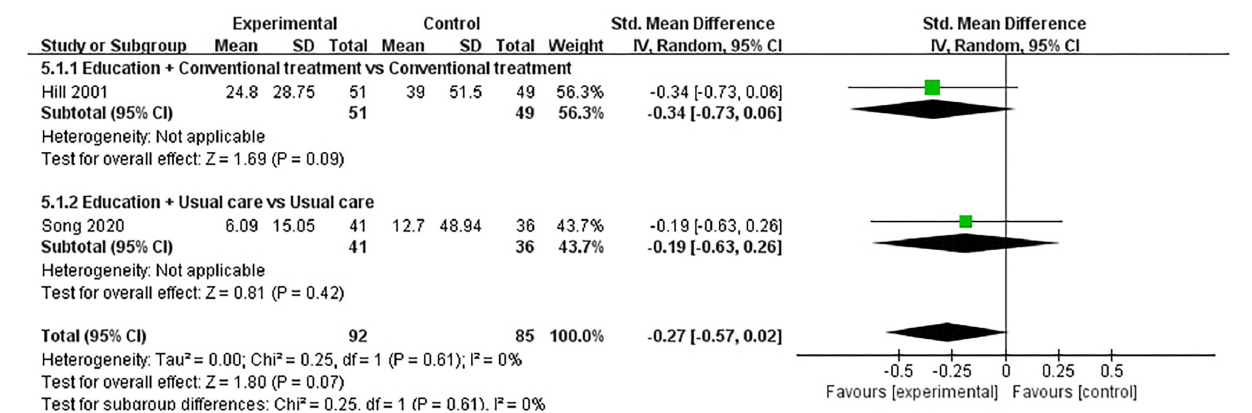
FIGURE 6 | Meta-analysis on CRP.